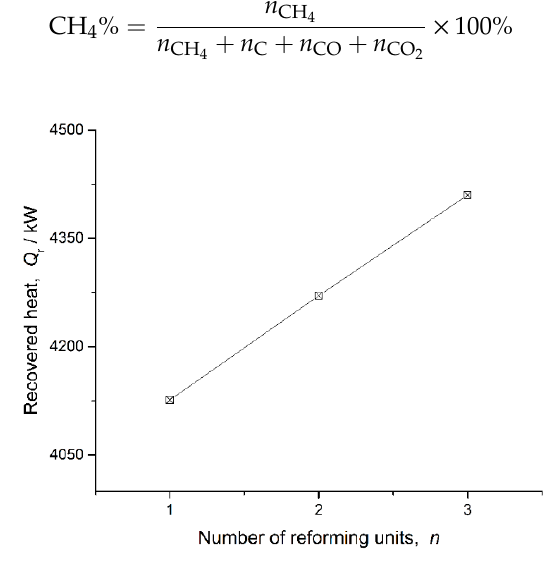
Figure 9. Recovered heat for chemical reformers with different numbers of reforming units.